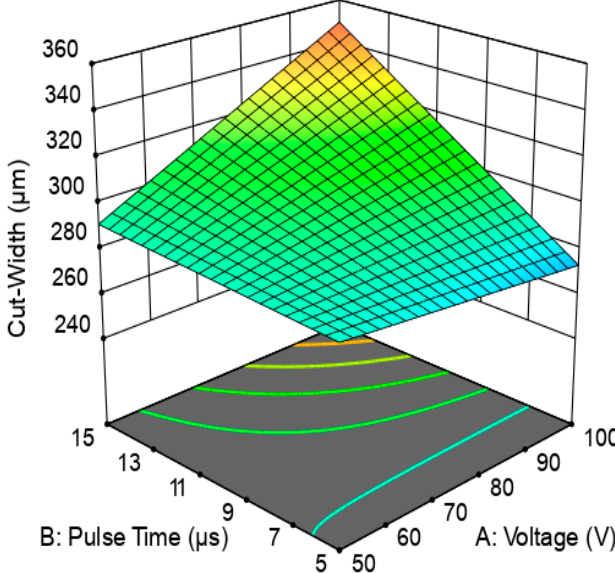
Figure 9. Response surface 3D-plot for cut-width dependence on voltage and pulse duration for pause time Toff = 30 µ s.